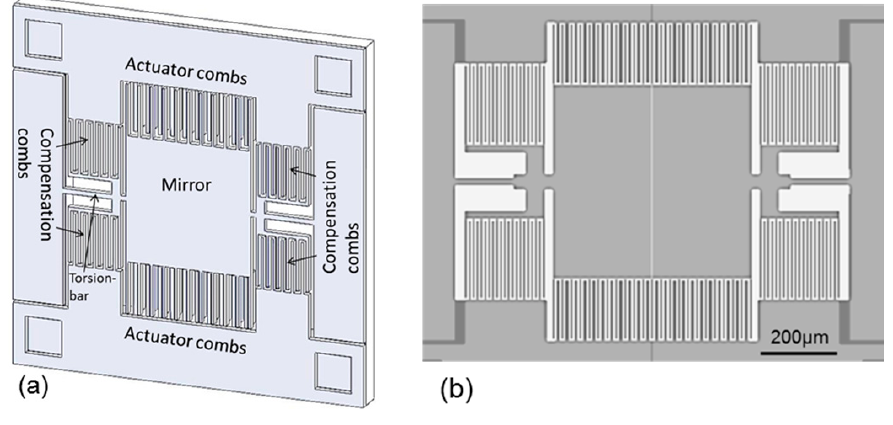
Figure 5. Schematic diagrams of scanner: ( a ) oblique view; and ( b ) top view. On the other hand, the compensation combs are located around the torsion-bars as shown in Figure 5. The movable and fixed fingers of the compensation combs are 205 µ m in length, 5 µ m in width, and 20 µ m (symbol b ) in thickness. The gap ( g ) between the movable and fixed comb fingers is 5 µ m. The distance ( l ) from the rotation axis to the end of movable fingers is 300 µ m, and the distance ( a ) from the rotation axis to the end of fixed fingers is 100 µ m. The width of the compensation comb fingers is 5 µ m. The number of the finger gaps of each compensation comb is